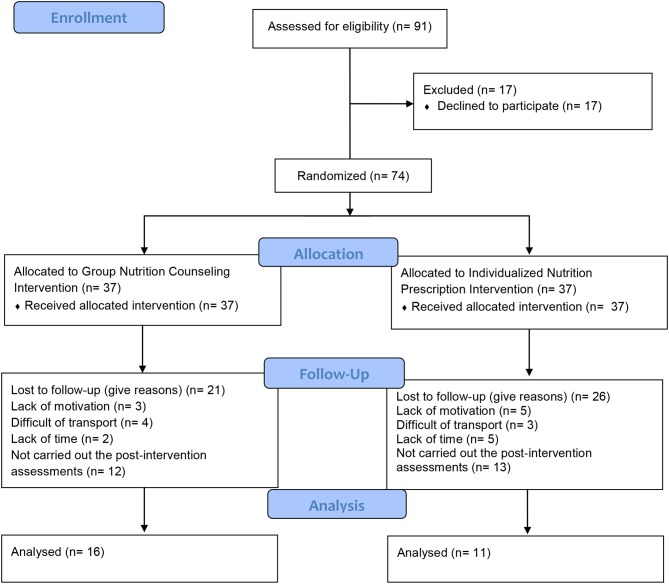
Flowchart of present study.